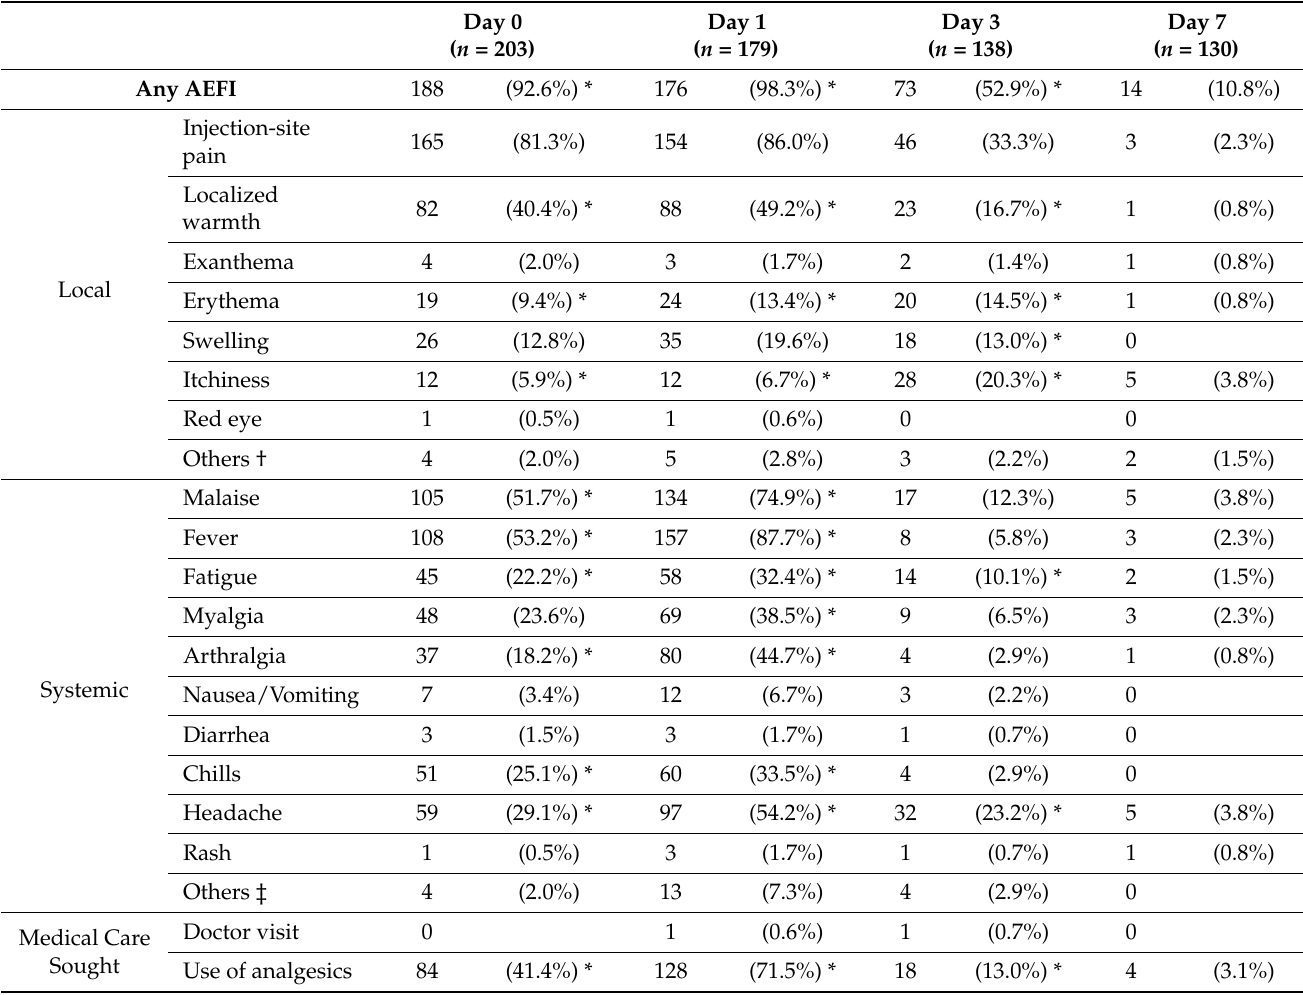
Table 3. Adverse events following immunization (AEFIs) for the second dose. AEFIs: adverse (Table 2). † Other local AEFIs include nasal mucus, sore throat, and others. ‡ Other systemic AEFIs include dizziness, palpitation, sweating, and others. Day 0 is defined as the day of